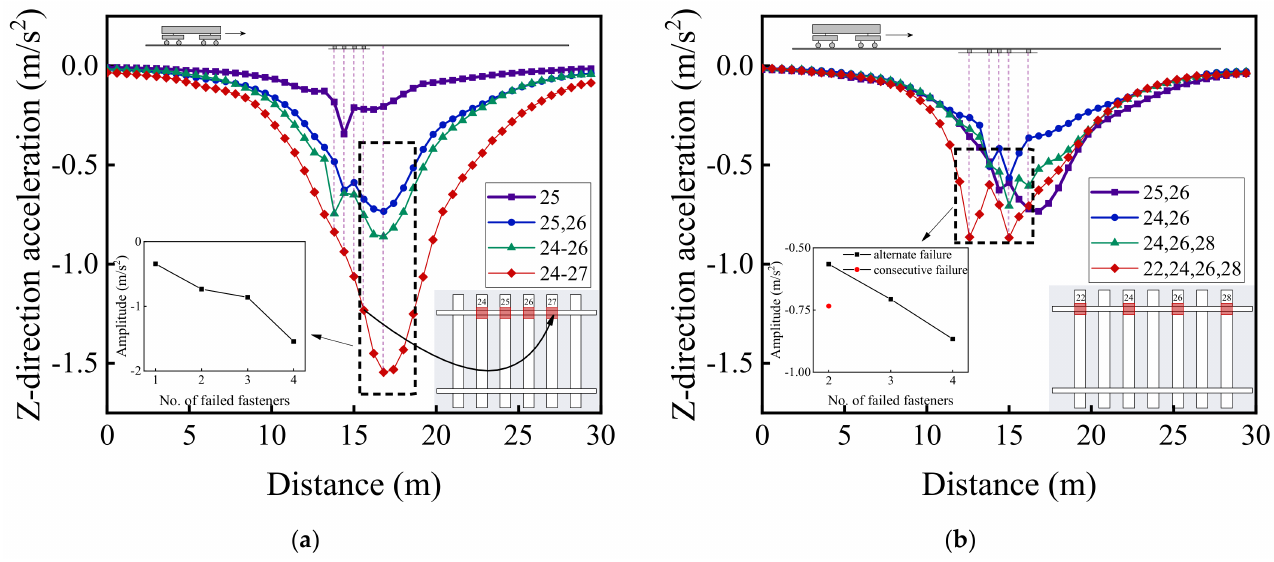
Figure 23. The longitudinal variations of vertical acceleration responses of ballasts (under No. 1 to No. 50 rail node) at the side with ( a ) single-side consecutively failed fasteners and ( b ) single-side alternately failed fasteners.